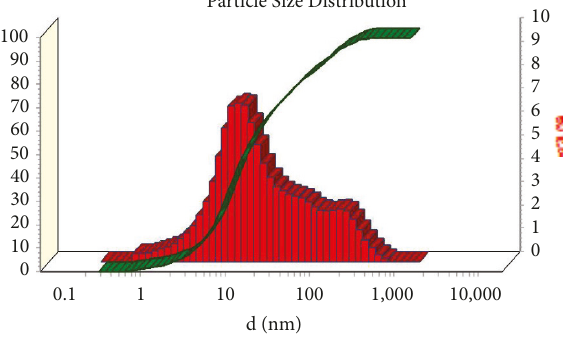
Figure 2: Particle size analysis of